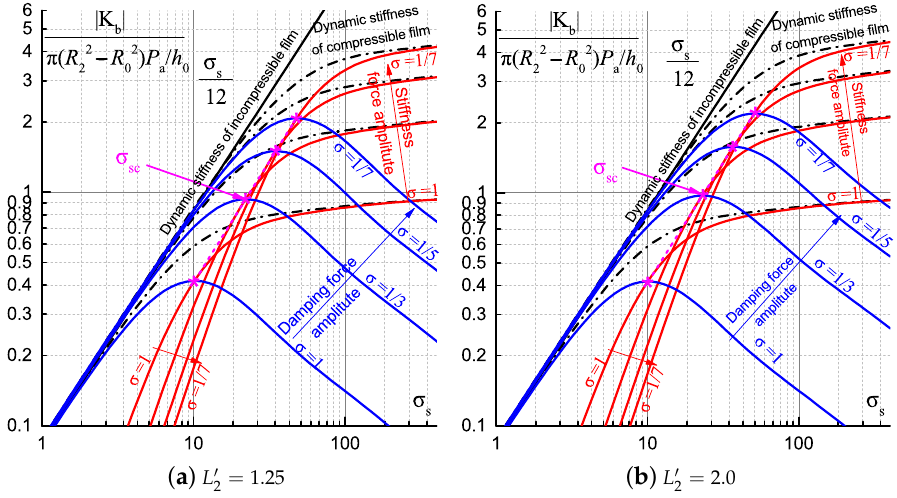
Figure 18. Dynamic stiffness modulus of the 1D ring with supply pressure under different radius ratios (flows from